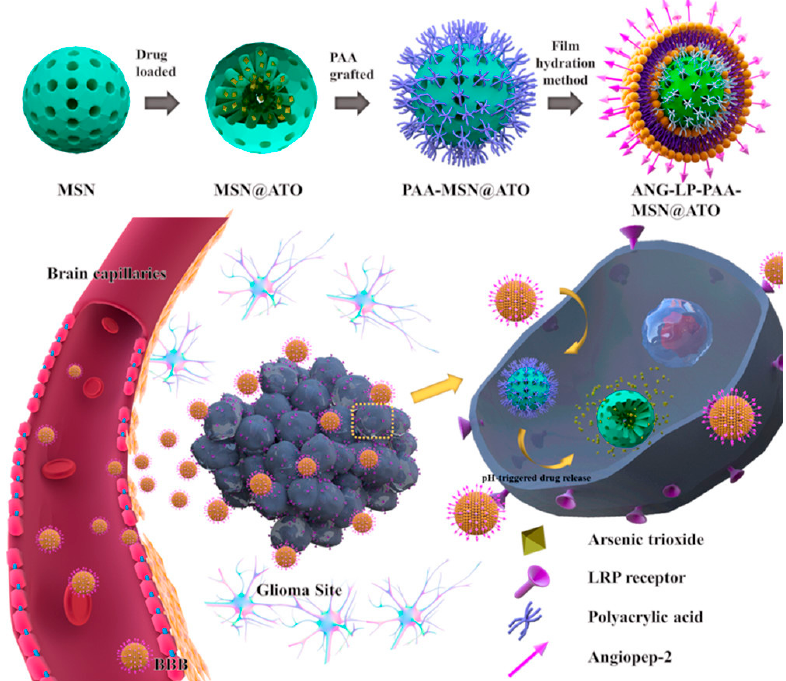
Figure 10. Graphical representation of the synthesis of PAA coated MSNs and their encapsulation in liposomes for glioma therapy [42].